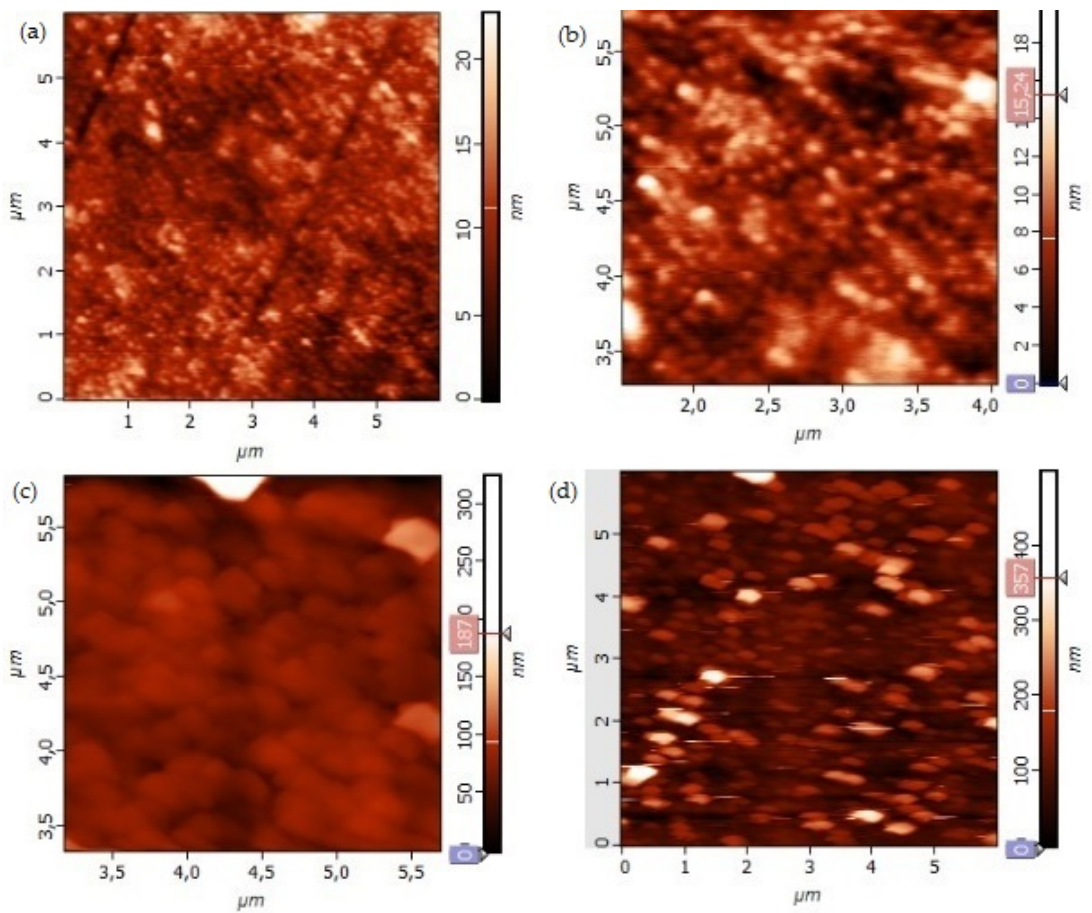
Figure 2. AFM images of thin films on a GaAs surface obtained at 515 °C under the influence of composites ( a ) (Y 2 O 3 ) 0.8 (Sb 2 O 3 ) 0.2 ; ( b ) (Y 2 O 3 ) 0.6 (Sb 2 O 3 ) 0.4 ; ( c ) (Y 2 O 3 ) 0.4 (Sb 2 O 3 ) 0.6 ; ( d ) (Y 2 O 3 ) 0.2 (Sb 2 O 3 ) 0.8 .